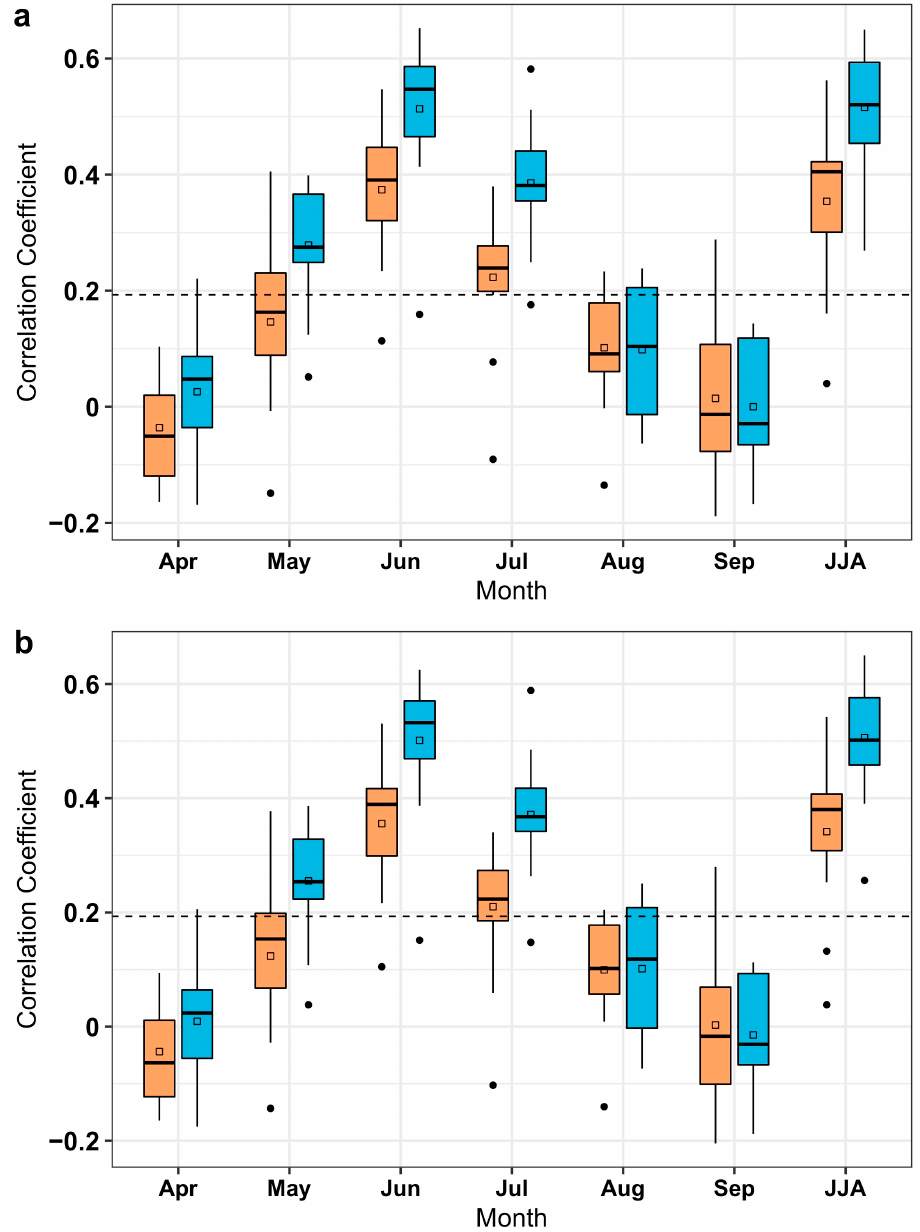
Figure 2. Correlation coefficient of co-occurring Carya ovata (orange) and Quercus alba (blue) chronologies with ( a ) climatic water balance and ( b ) standardized precipitation evapotranspiration index (SPEI) at 15 sites from April to September as well as June-July-August (JJA) of current growing season during the common period 1908–2011. Horizontal dash line indicates 0.05 significance level.